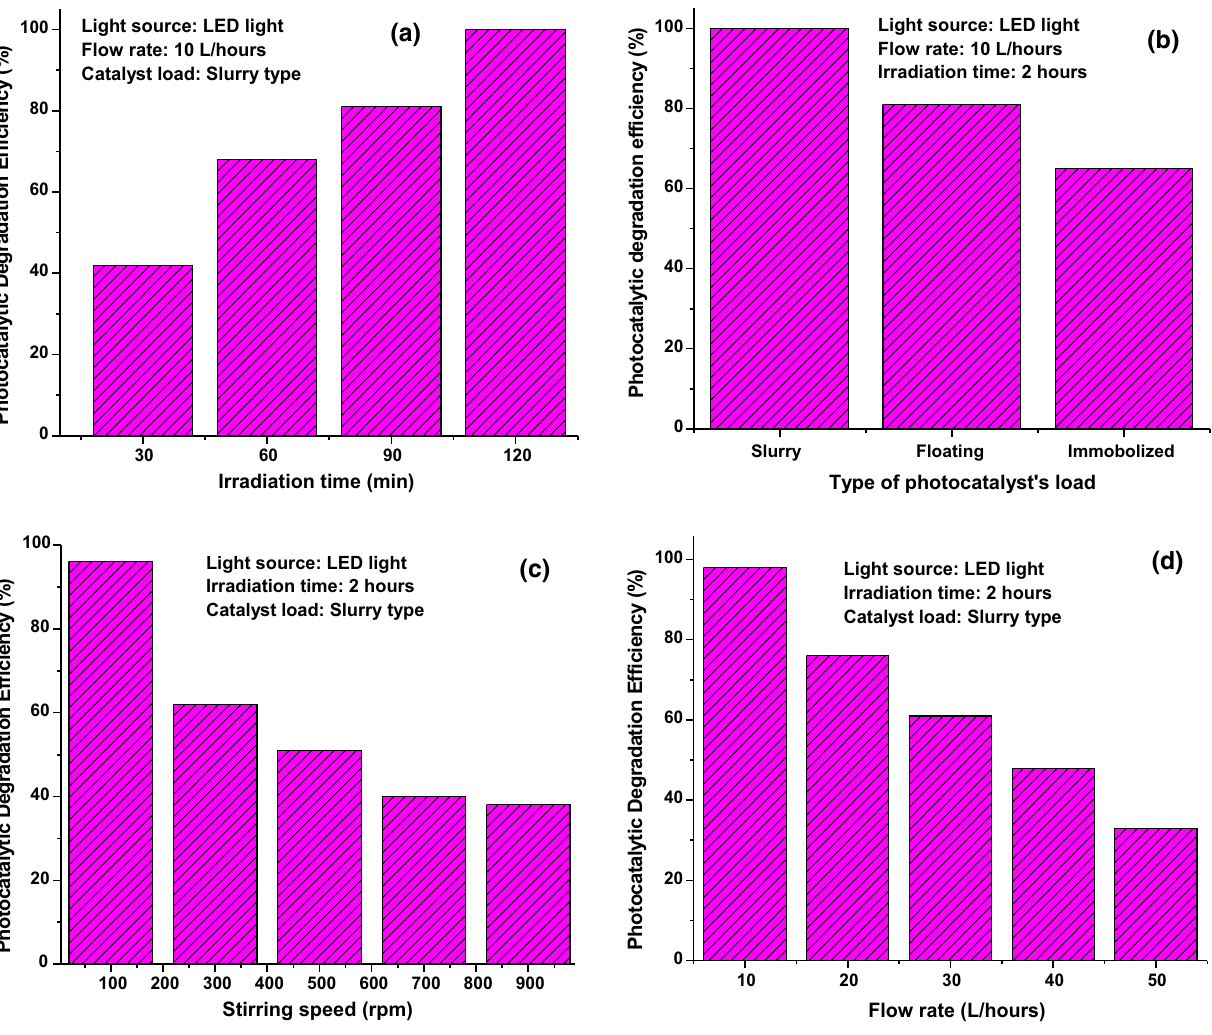
Fig. 12 Photocatalytic degradation of chlorobenzene using continuous (vertical) photoreactor setup a effect of irradiation time; b effect of photo- catalyst’s loading type; c effect of irradiation time; d effect of flow